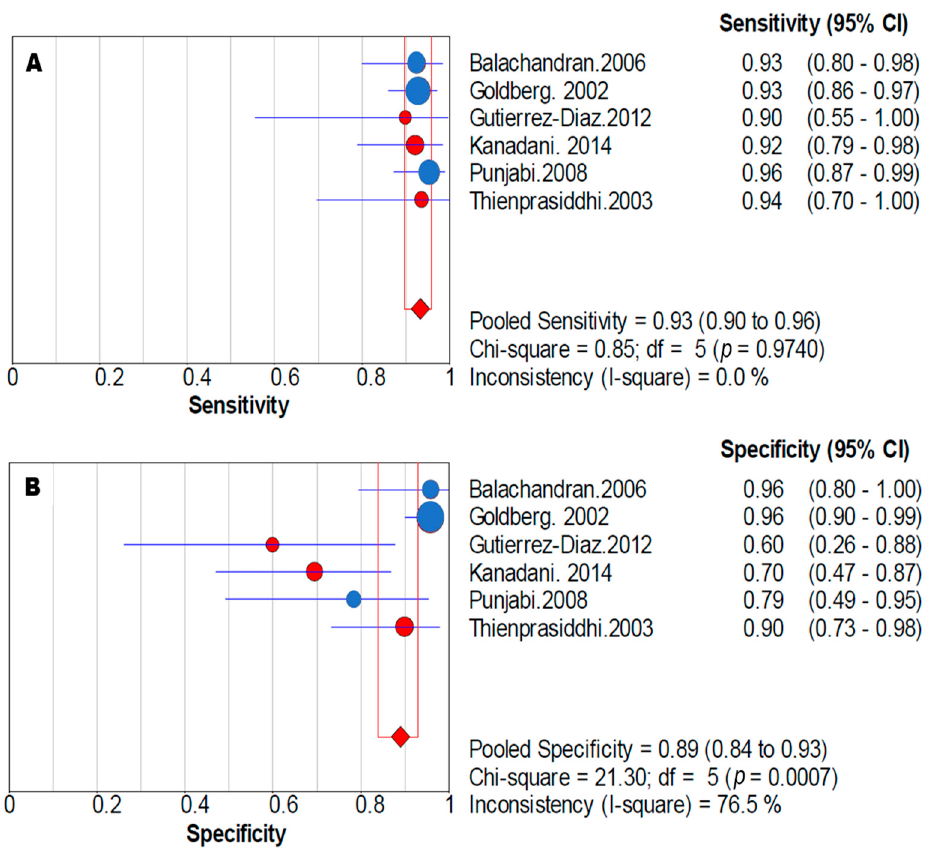
Figure 3. Sensitivity and specificity forest plots in the meta-analysis. Forest plots of sensitivity ( A ) and specificity ( B ) corresponding to the amplitude of mfVEP to diagnose visual field defects in glaucoma. Pooled sensitivity was 0.93 (95% CI: 0.90–0.96) and pooled specificity was 0.89 (95% CI: 0.84–0.93). The size of each point is proportional to the study sample size or the weight of the study in the meta-analysis. The blue points represent studies with Accumap equipment and the red points are with Veris equipment.